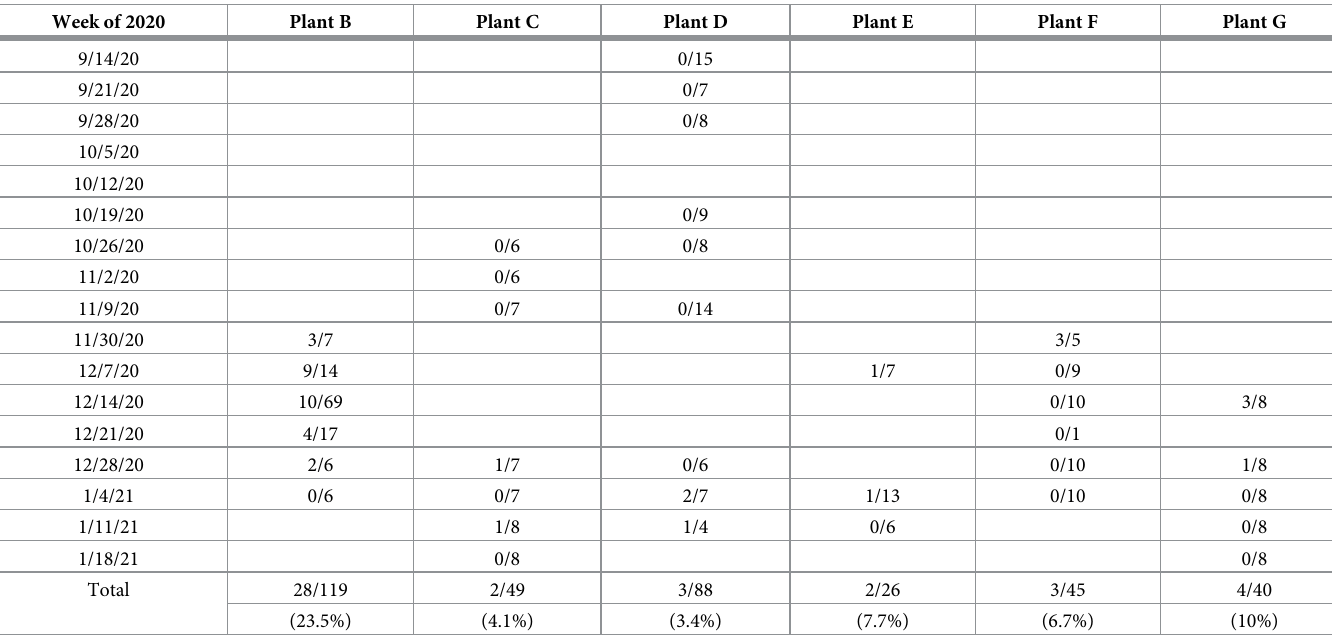
Table 2. Phase 2 surface and air sample